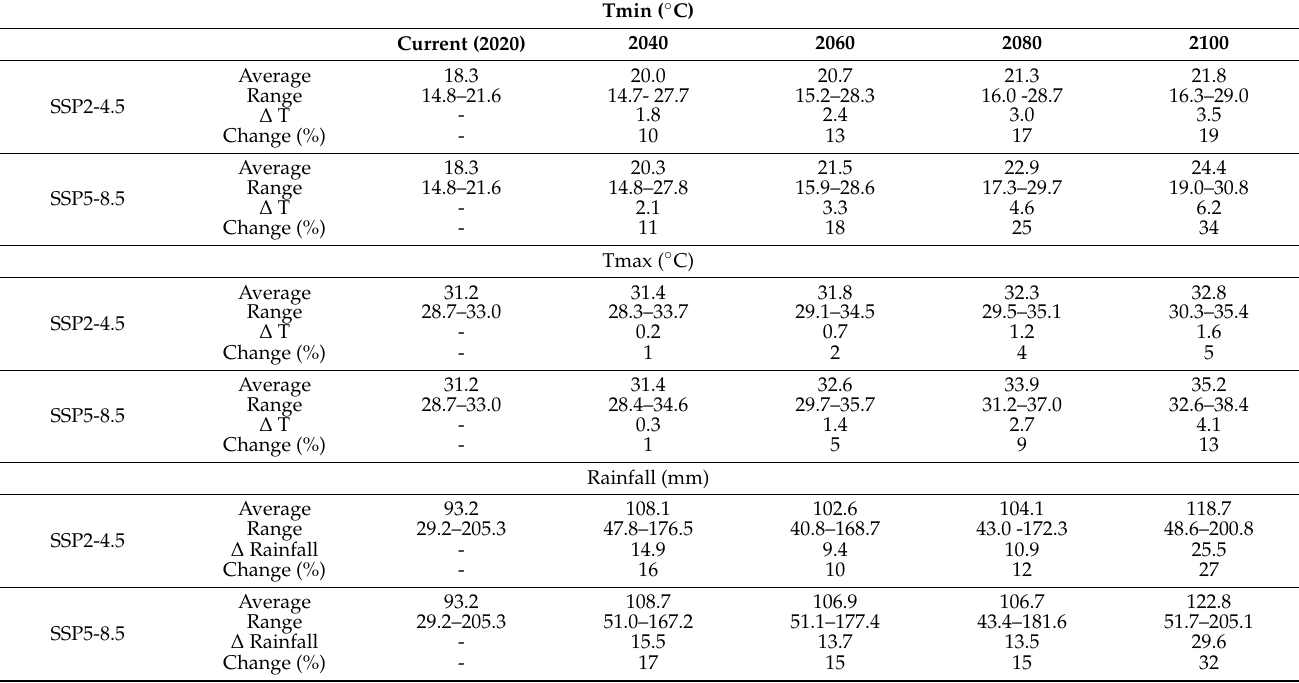
Table 4. Minimum and maximum temperatures ( ◦ C) and rainfall (mm) (average, range, difference, and change) using the four CMIP6 climate models for the four periods (2040, 2060, 2080, and 2100) under SSP2-4.5 and SSP5-8.5 and current conditions